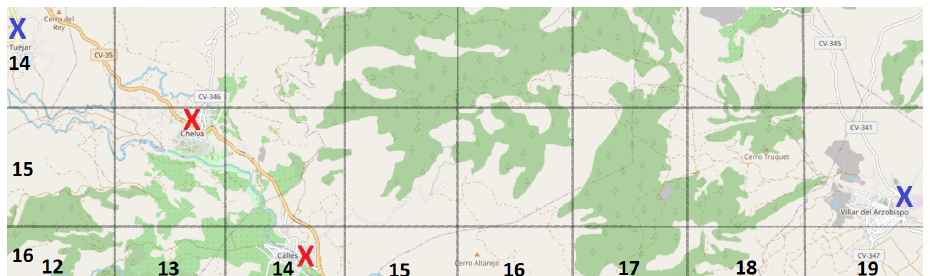
Figure 8. Small part of the province divided as the matrix P would do. The numbers at the bottom imply the column numbers and those on the left border the row numbers. The red Xs are placed where the current forest fire stations are, and the blue Xs represent the same stations in their optimized